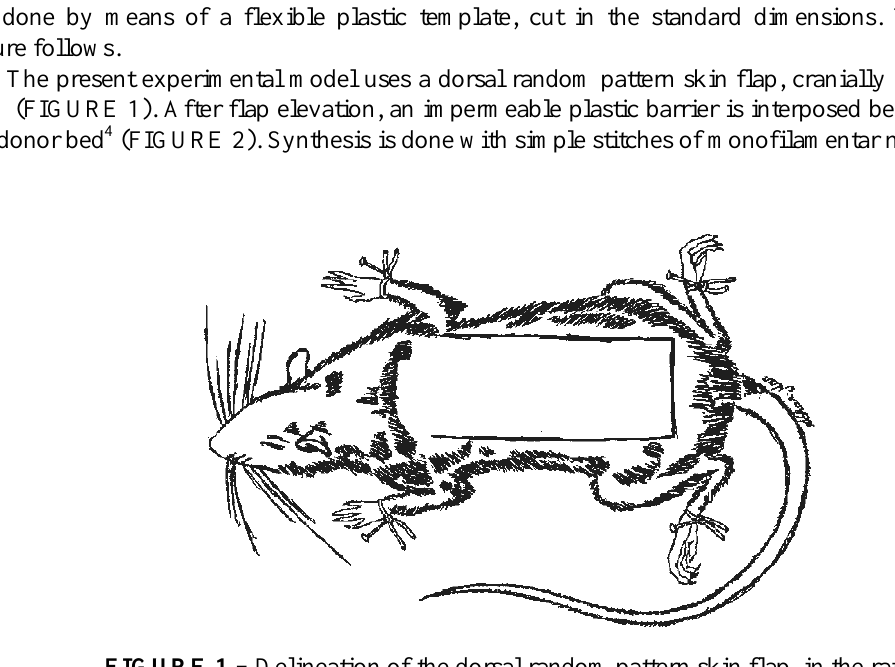
FIGURE 1 – Delineation of the dorsal random pattern skin flap, in the rat.